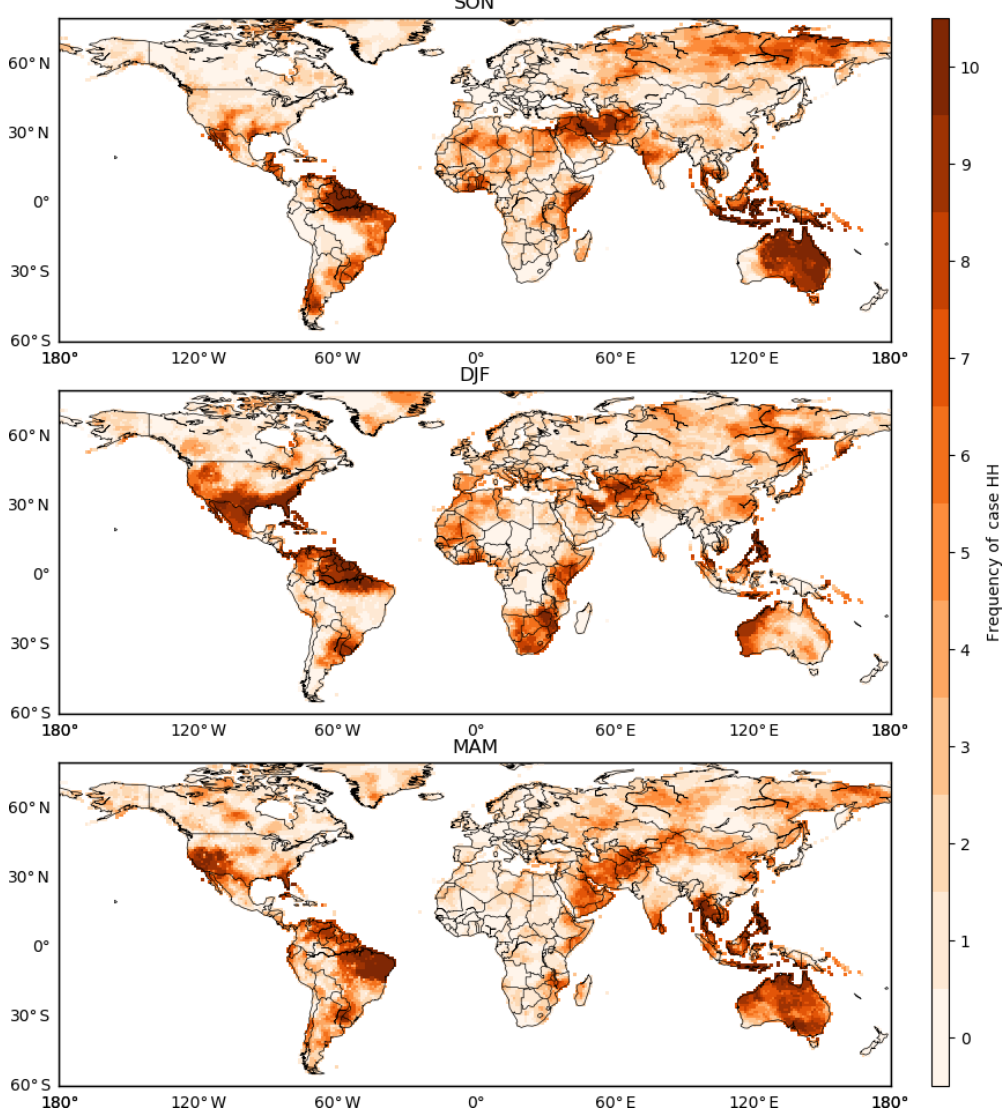
Figure 6. As for Fig. 4 but for SON, DJF, and